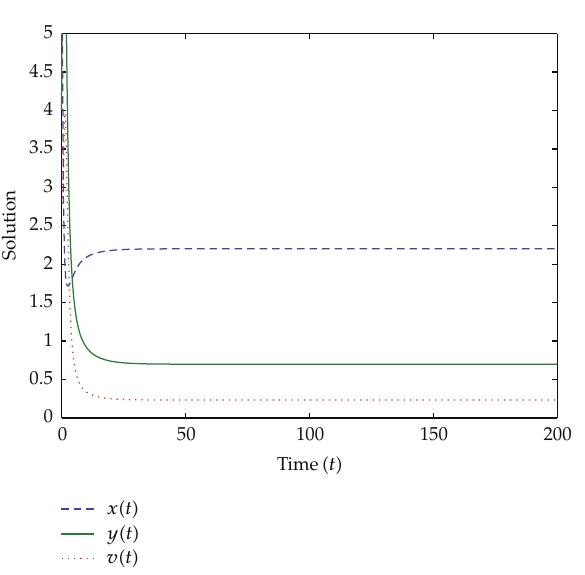
Figure 1: The numerical solution of system (cid:3) 1.4 (cid:6) when α (cid:8) 2, β (cid:8) 2, λ (cid:8) 4, a (cid:8) 1, d (cid:8) 1 . 5, k (cid:8) 2, u (cid:8) 3, τ (cid:8) 1, and (cid:3) φ 1 ,φ 2 ,φ 3 (cid:6) (cid:8) (cid:3) 10 , 4 , 6 (cid:6)